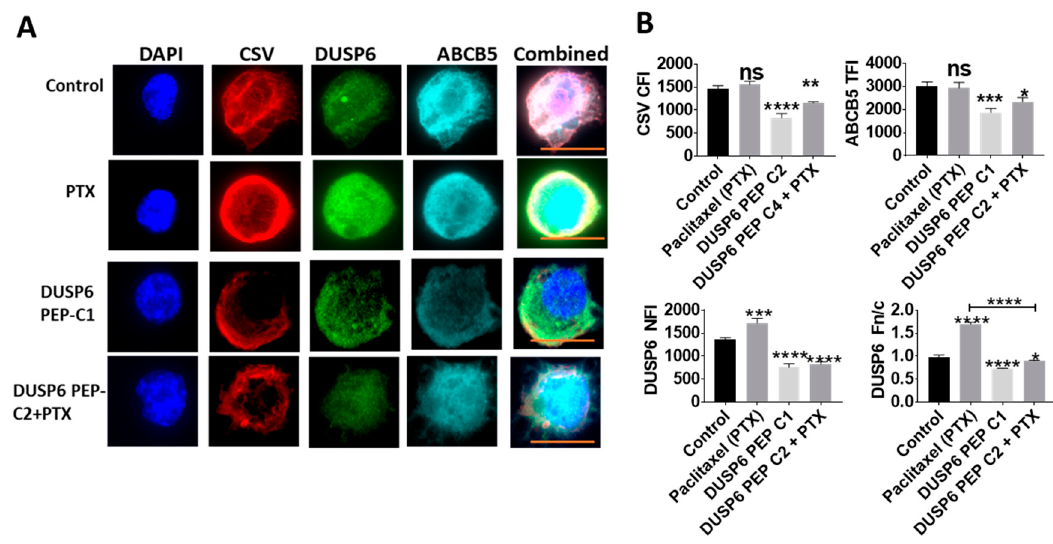
Figure 4. Inhibition of nuclear DUSP6 with novel peptide inhibitor. DUSP6, CSV and ABCB5 were labelled in TNBC cell line, MDA-MB-231 and treated with either vehicle alone, Paclitaxel (PTX) or DUSP6 Nuclear Peptide inhibitor (DUSP6 PEP, C1 = 60mg/mL) or a combination (PTX + C2 40mg/mL) with n > 20 individual cells. Representative images for each dataset are shown ( A ). Graphs represent the Fn/c, nuclear fluorescence intensity (NFI), cytoplasmic fluorescence intensity (CFI) or total fluorescence intensity (TFI) measured with the ASI automated digital pathology system ( B ). Scale bar is in orange and equals 10 µM. * p < 0.05, ** p < 0.01, *** p < 0.001, **** p < 0.0001 denote significant differences. ns denotes non-significant.